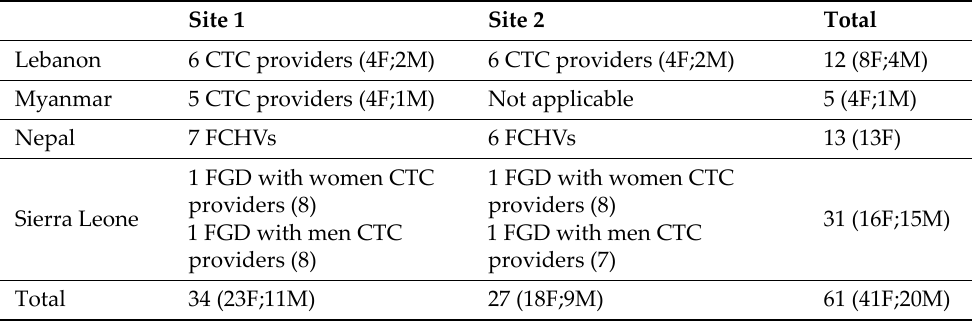
Table 2. Details of the CTC